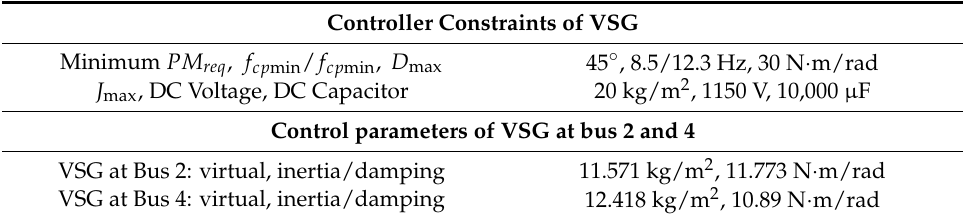
Figure 5. Test cases system: ( a ) four-machine two-area system containing VSG; ( b ) a typical microgrid containing three VSGs. Table 1. Case 1: Main simulation parameters of the VSG model.